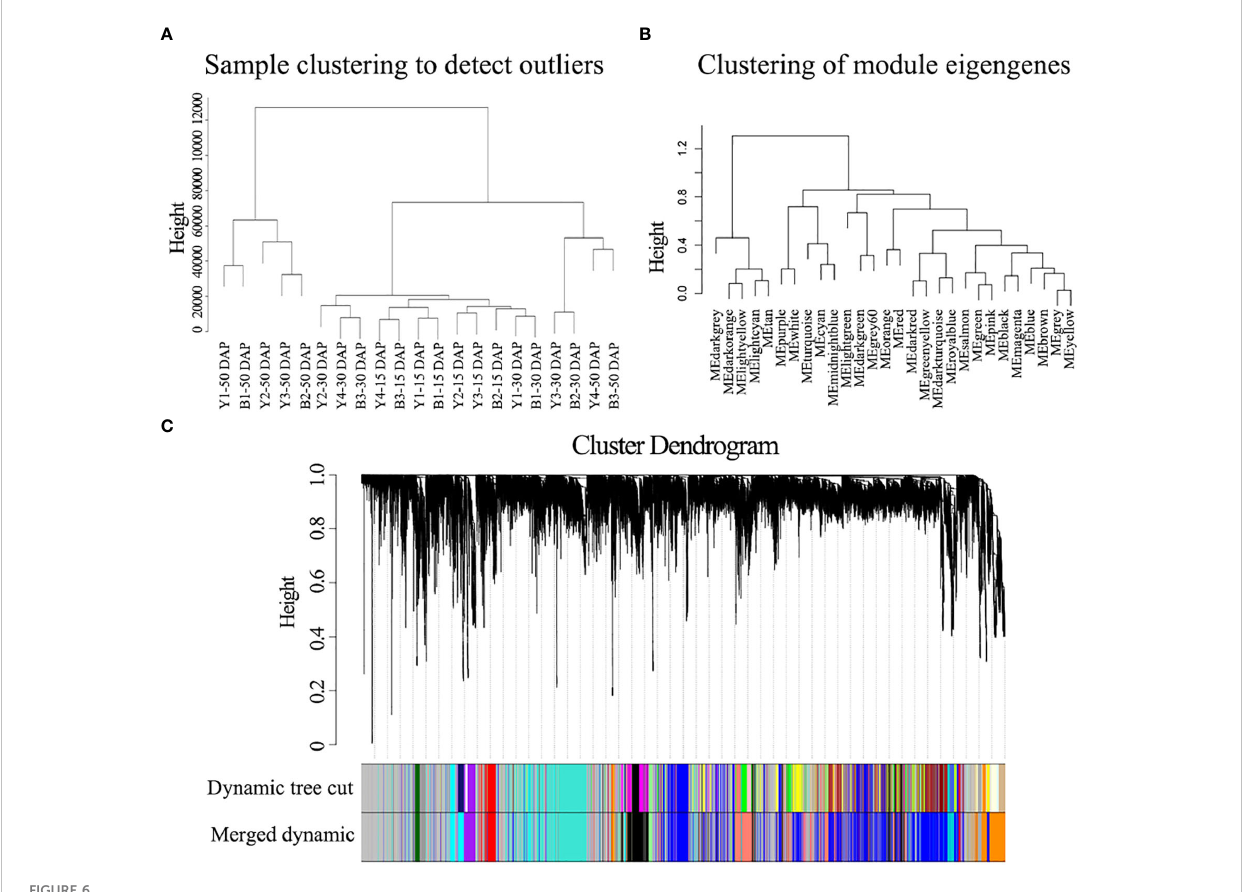
FIGURE 6 WGCNA of the gene expression matrix in seeds. (A) Clustering tree analysis of different samples. (B) Clustering tree analysis of different modules. (C) Clustering dendrogram of the average network adjacency for the identi fi cation of gene co-expression